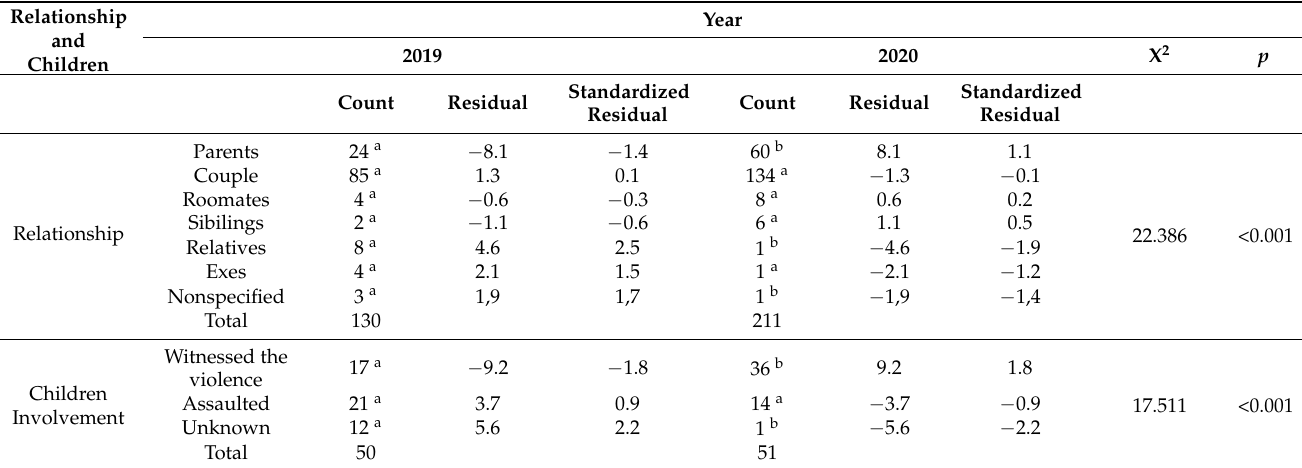
Table 3. Relationship and children involvement in the